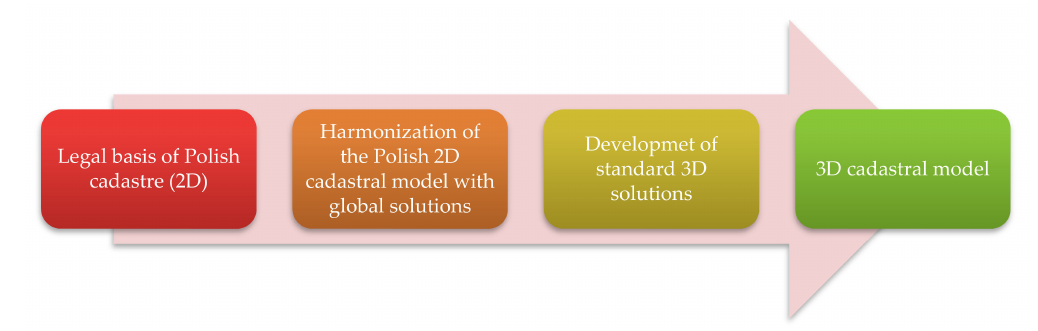
Figure 1. Scheme of conceptual work on the construction of the 3D cadastre